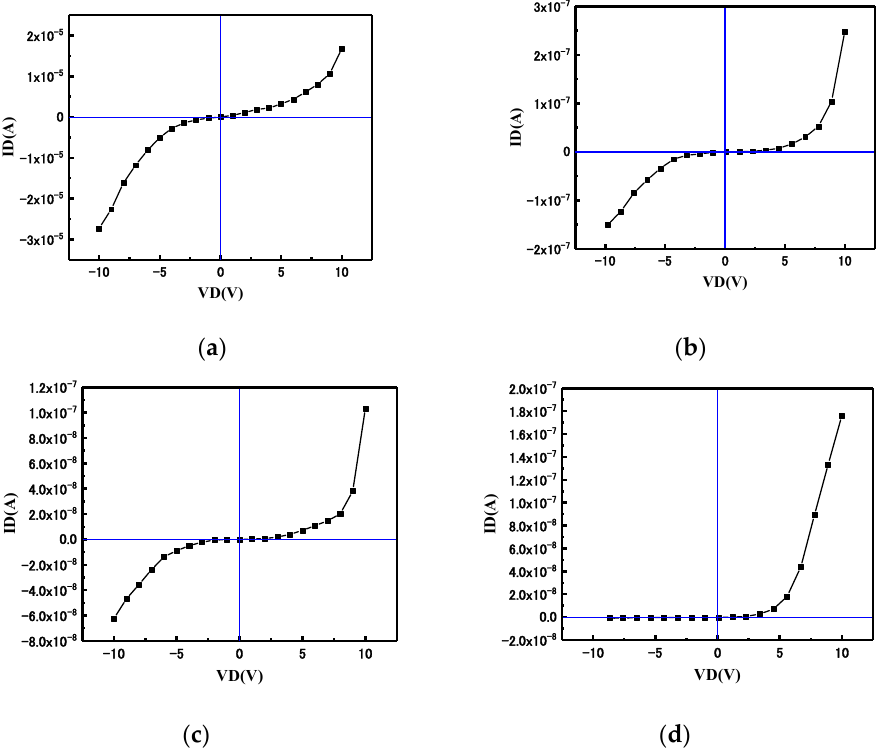
Figure 8. The I-V characters of SnO 2 :Si / SnO 2 :10 at.% Ga homojunction with di ff erent Si doping